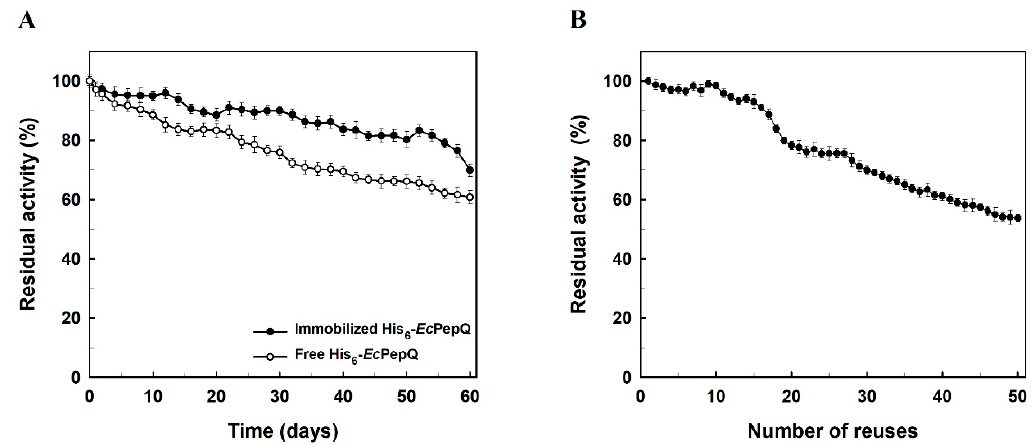
Figure 6. Operational stability ( A ) and storage stability ( B ) of the immobilized enzyme. The data are the average of three independent experiments with standard deviations.